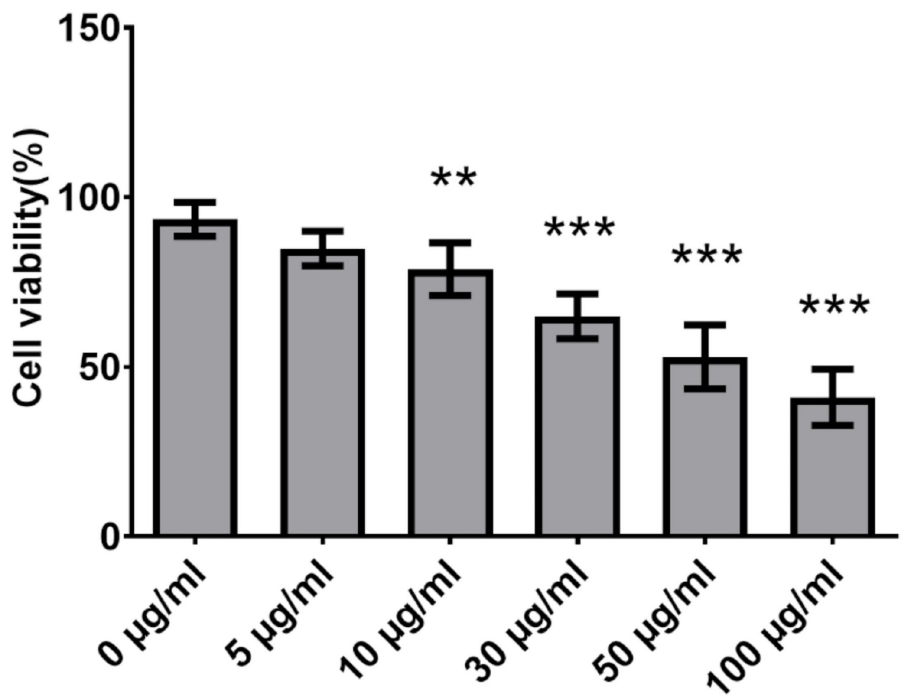
Fig 7. Cytotoxic effect of KPEVs on gastric cancer cells. The viability of the AGS cells was determined using the MTT assay after incubated with various concentrations of KPEVs for 24 h. The experiments were performed in at least triplicates, and the data are presented as the mean ± SD. The statistical analysis was performed using one-way ANOVA followed by the Bonferroni test. ( �� ) and ( ��� ) indicate a P-value of p � 0.01 and p � 0.001 compared to the media